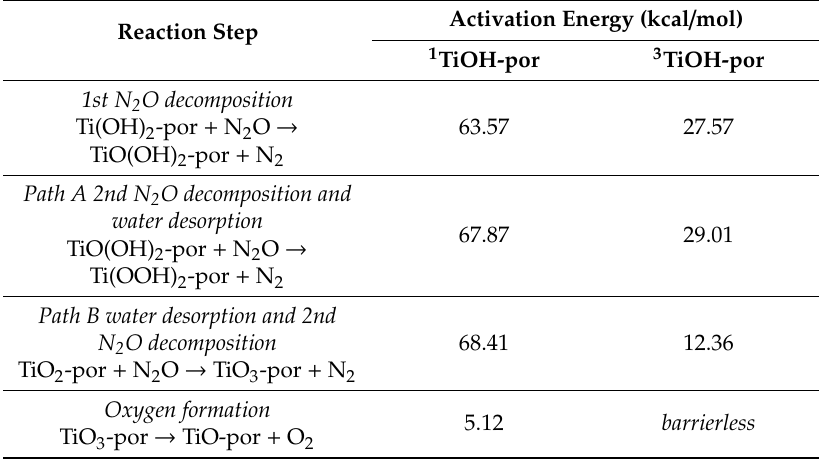
Table 1. Activation energy (kcal / mol) for N 2 O direct decomposition including the water molecule on singlet and triplet states of TiOH-por catalysts.